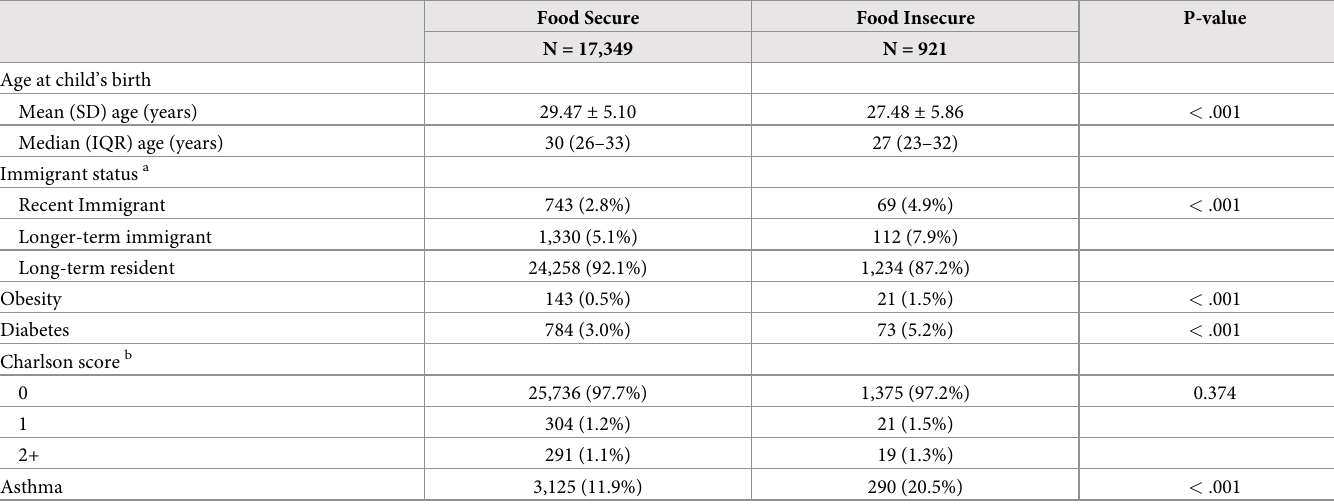
Table 3. Maternal characteristics of food insecure and secure children in Ontario, Canada.